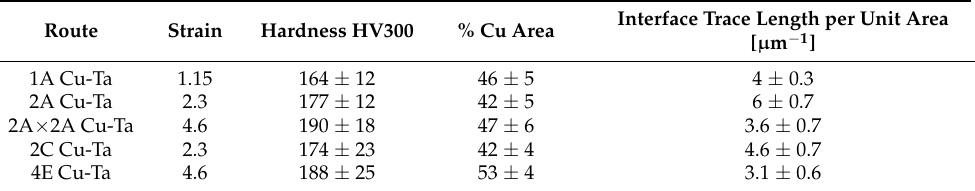
Table 1. Summary of total accumulated strain, Vickers hardness, % area of Cu phase, and phase boundary trace length per unit area for each ECAE processing route.